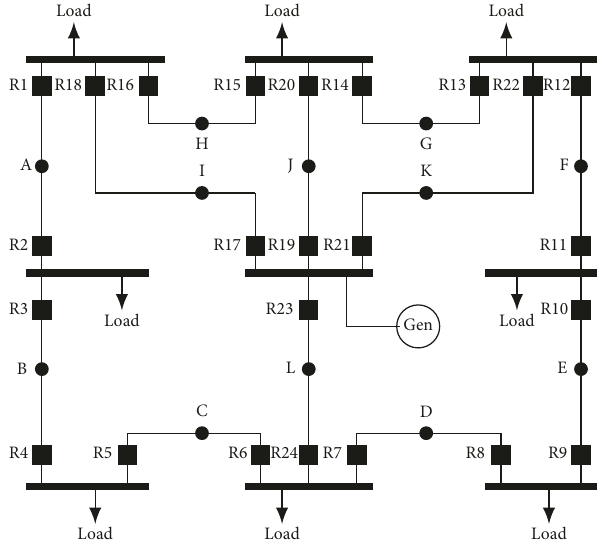
Figure 13: IEEE 9-bus DOCRs coordination problem